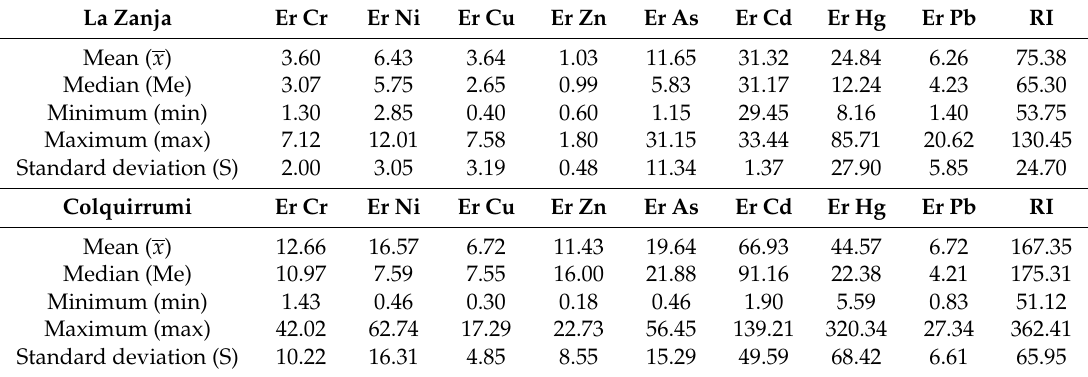
Table 5. Ecological individual risk (E r i ) and potential ecological risk index (RI) of the soils studied. La Zanja Er Cr Er Ni Er Cu